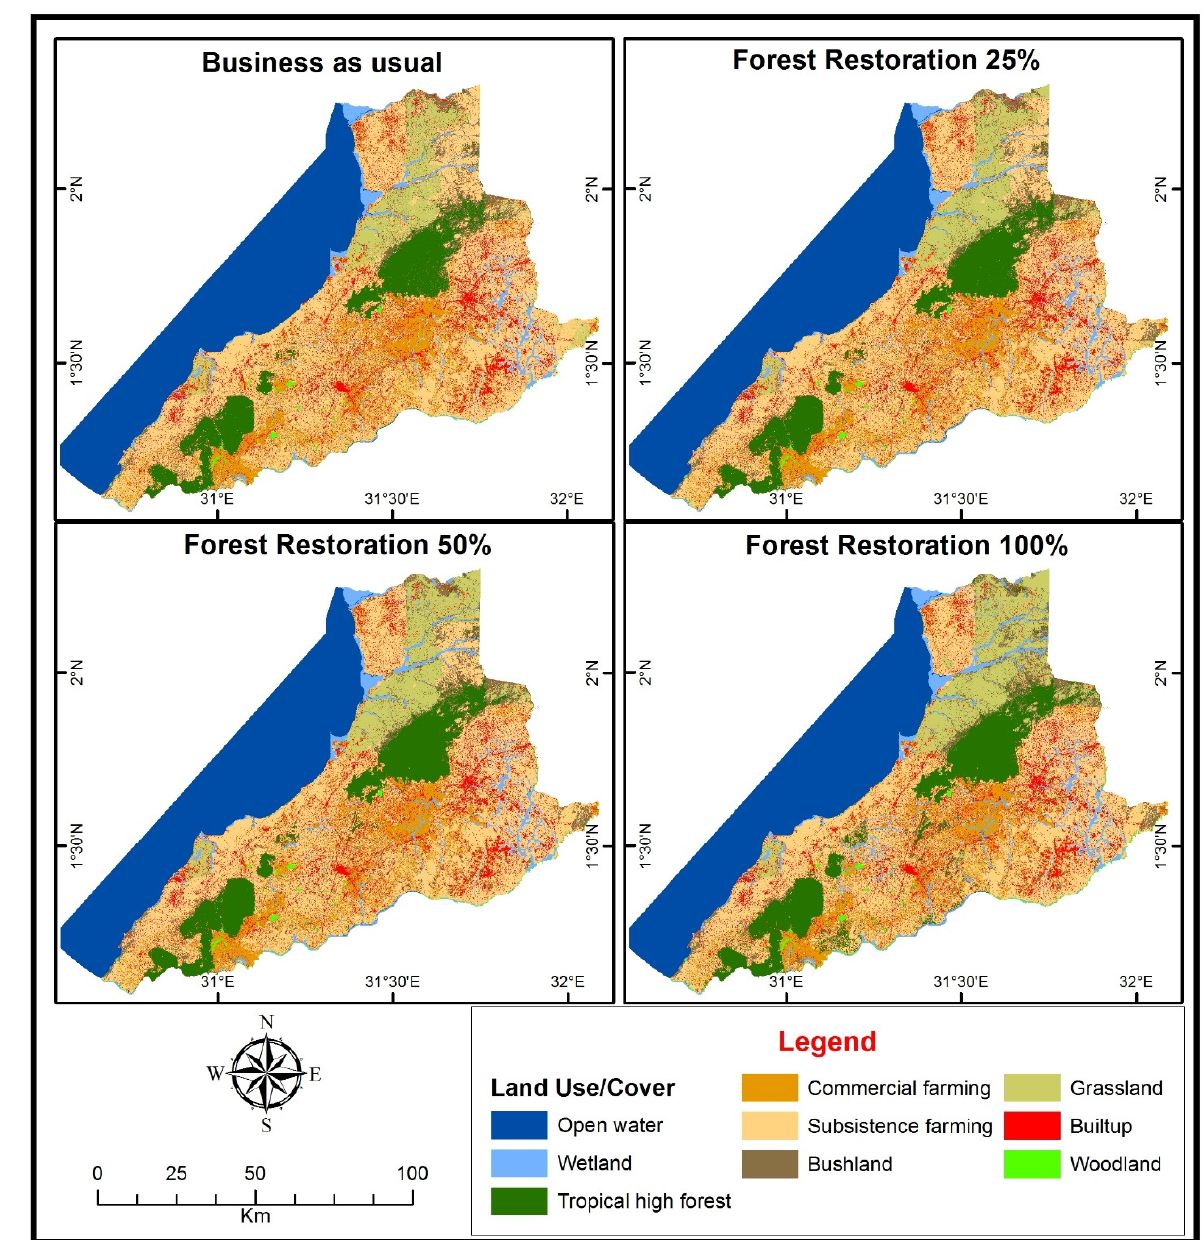
Figure 4. LULCC prediction maps for Budongo–Bugoma landscape under different scenarios in 2040. The restoration of forests to 25% predicted an improvement in forest cover by 0.7%, with commercial farmland and subsistence farmland predicted to continue expanding but at nearly a quarter less than business as usual rates (2.7%, 3.9% respectively), while built-up areas would remain high at 4.2%. On the flip side, wetlands would be encroached on while grasslands would continue to be converted at rates of 0.7% and 10.7%,